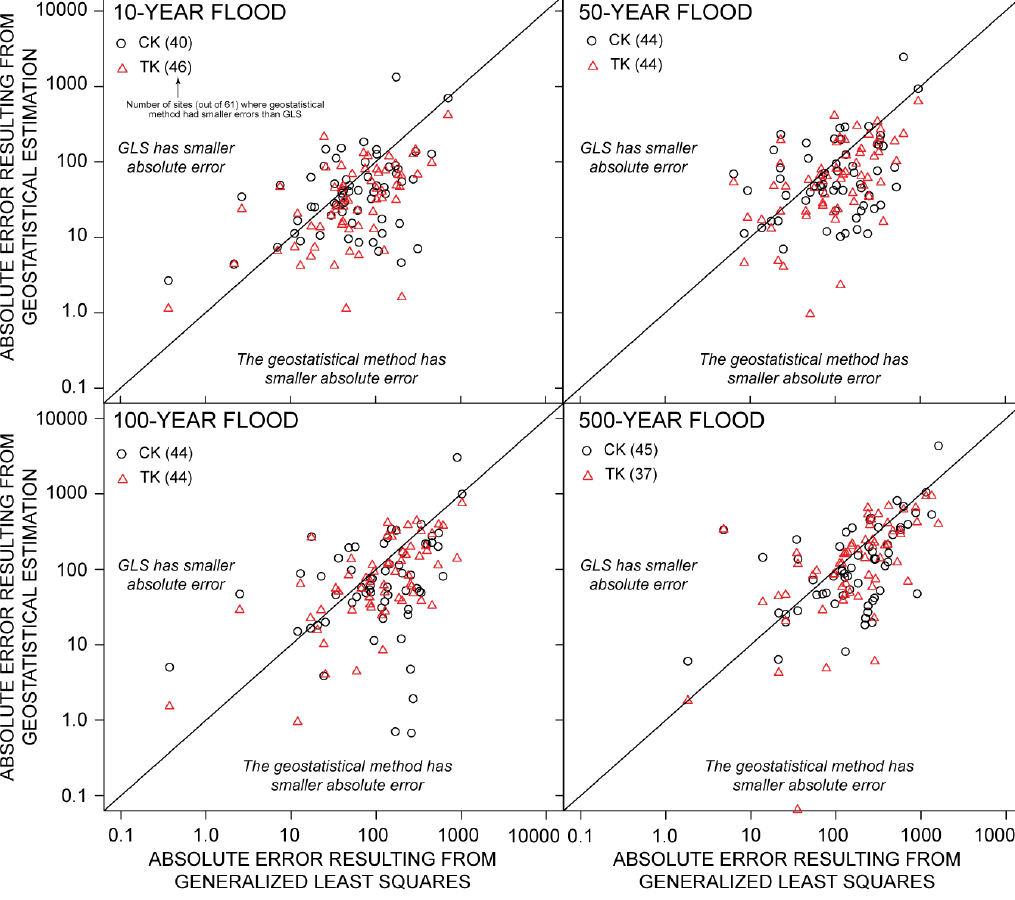
Fig. 4. Comparison of the absolute error between empirical and predicted flood quantiles resulting from topological and canonical kriging to the absolute error resulting from generalized least squares